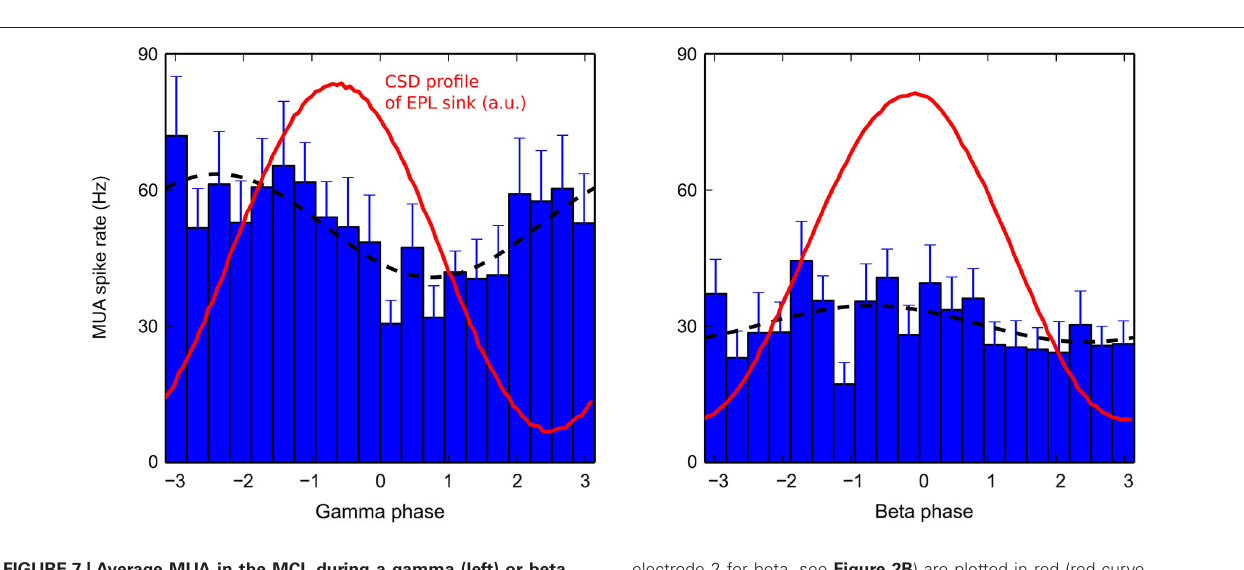
FIGURE 7 | Average MUA in the MCL during a gamma (left) or beta (right) cycle . Average MUAs (bar plots) during gamma (left) or beta (right) oscillations are fitted with a sine function (black dashed lines). To compare with the corresponding CSD dynamics in the EPL, the time evolution of EPL sinks (taken from electrode 4 for gamma, and from